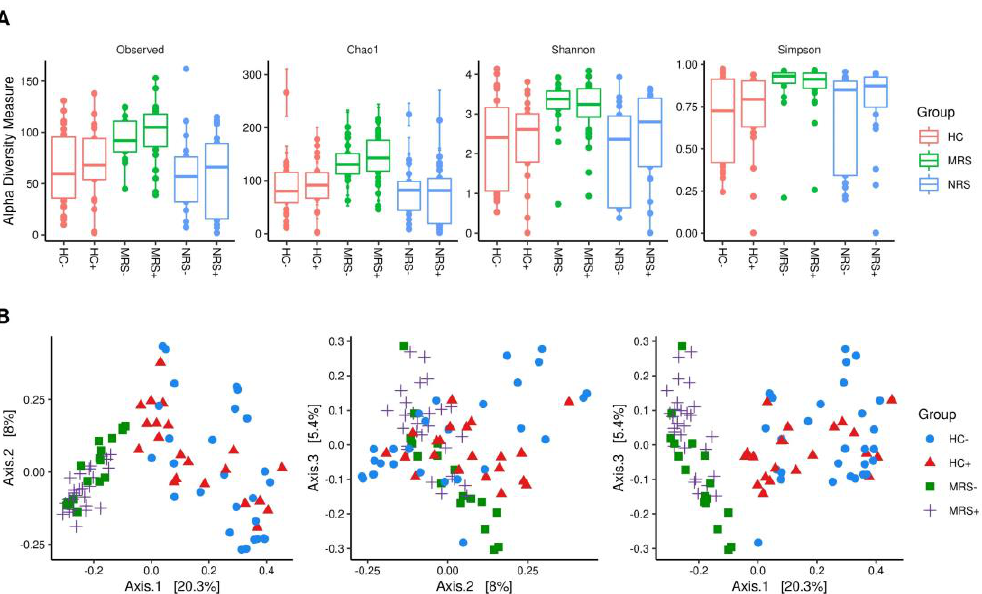
Figure 2. ( A ) Bacterial alpha diversity in the different studied samples. The type of sample is shown on top of graphics as MRS (Mother Rectal Swab), HC (Human Colostrum), NRS (Neonate Rectal Swab), while positive (+) or negative ( − ) results for SARS-CoV-2 genome detection by RT-ddPCR are shown at the bottom. The Y-axes indicate the values for the Observed number of species, Chao1, Shannon, and Simpson diversity indexes, respectively. Supplementary Material (Supplementary Materials Table S6). ( B ) Beta diversity of bacteria in MRS and HC. The graphics show beta-diversity analyses calculated by dissimilarity metrics using features tables and Unweighted UniFrac analysis. The scatter plots were generated using principal coordinates analysis (PCoA) in three different axes showing the percentage of total differences. The positive (+) or negative ( − ) SARS-CoV-2 genome detection by RT-ddPCR is shown beside the type of labels identified for the samples on the right side of the graphics. MRS and HC differed significantly according to ANOSIM ( p = 0.001).